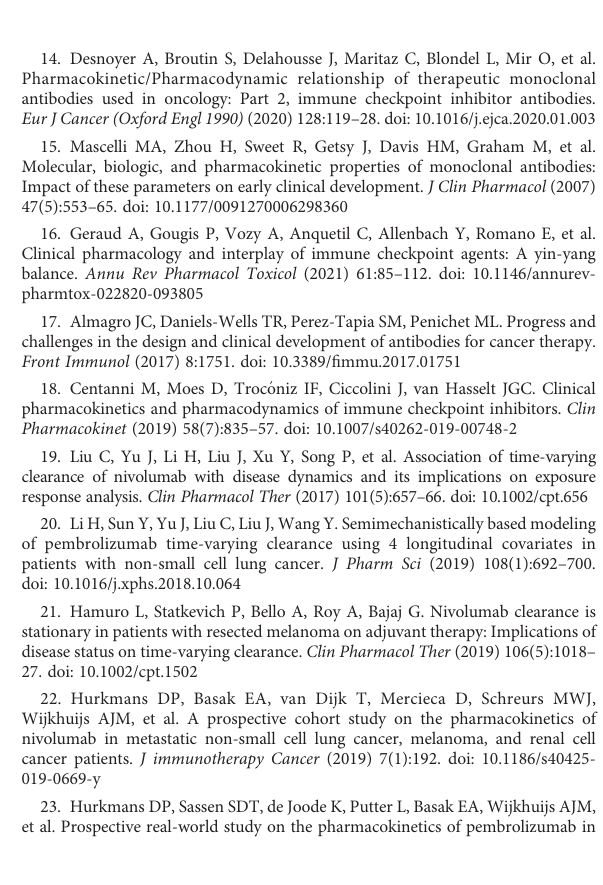
SUPPLEMENTARY FIGURE 1 The percentage of explained and unexplained CL (A) and V C (B) variability in the base and fi nal models for nivolumab, pembrolizumab, dostarlimab and camrelizumab. SUPPLEMENTARY FIGURE 2 The effects of included covariates on CL of (A) pembrolizumab, (B) dostarlimab, (C) cemiplimab and (D) camrelizumab. SUPPLEMENTARY TABLE 1 The effects of included covariates on V C of nivolumab, pembrolizumab, dostarlimab and